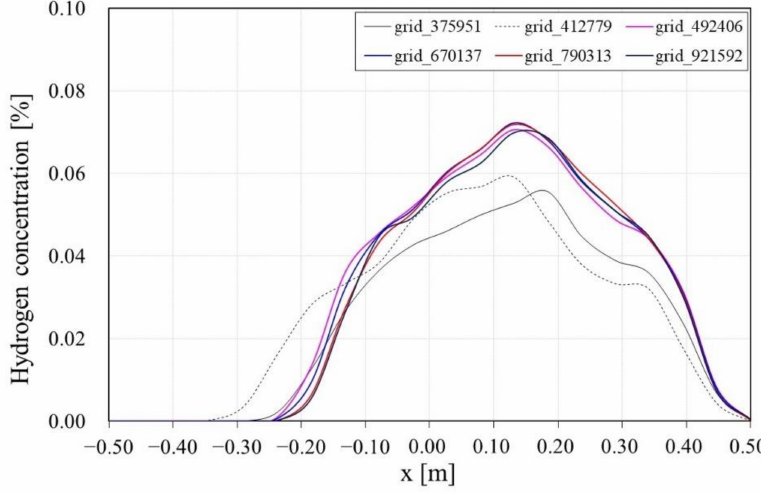
Figure 4. Grid independence test (H = 0.735 m, Time = 60